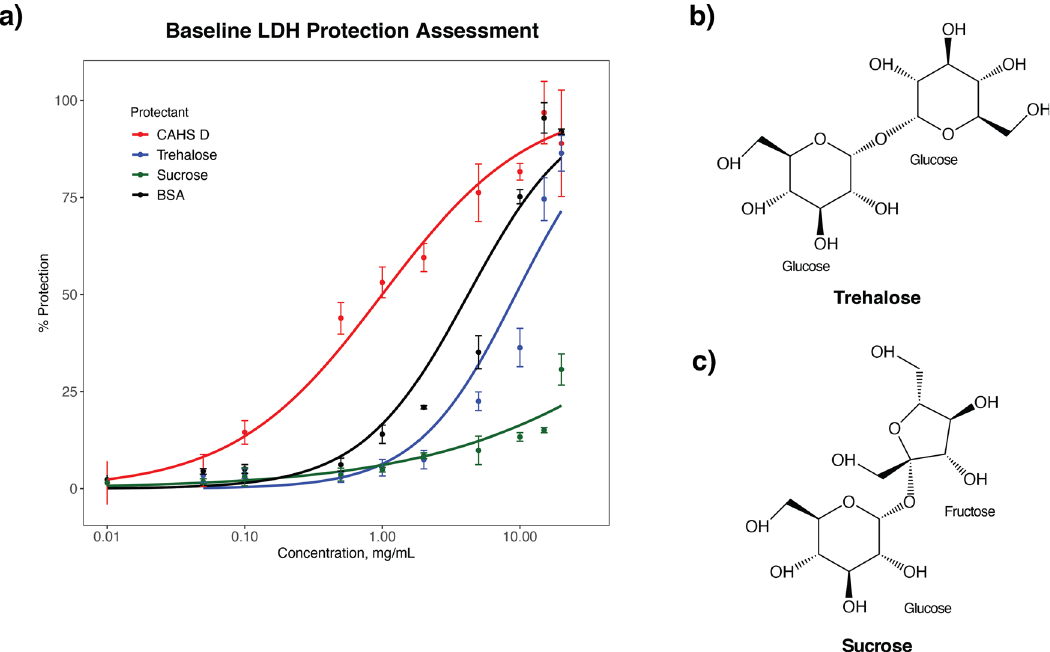
Fig. 3 Lactate dehydrogenase protection assay baseline values for CAHS D, trehalose, sucrose, and BSA. a Plot showing the percent protection of LDH conferred by each protectant as a function of concentration (mg/mL). n = 3, Error bars = standard deviation. b The molecular structure of trehalose. c The molecular structure of